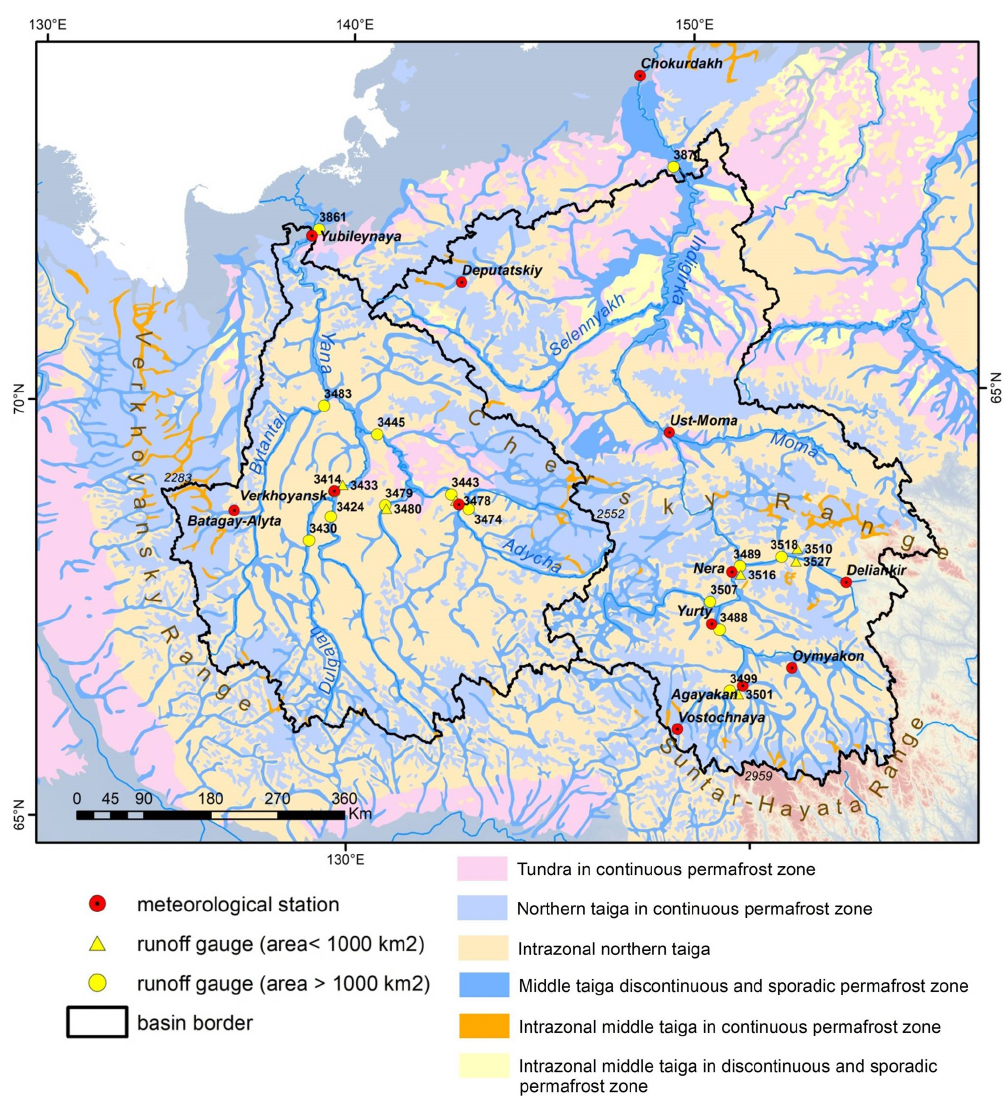
Figure 2. Landscape distribution within the study basins according to the Permafrost–Landscape Map of the Republic of Sakha (Yakutia) on a Scale 1 : 1500000 (Fedorov et al.,